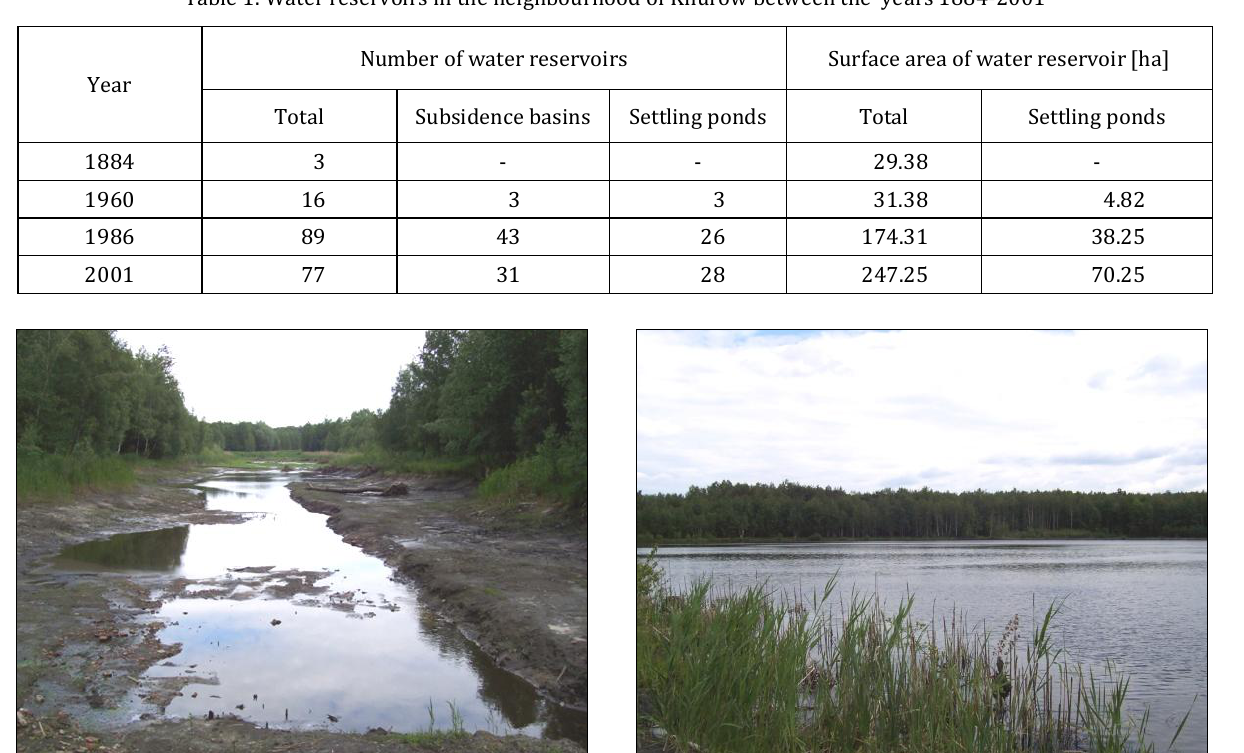
Table 1. Water reservoirs in the neighbourhood of Knurów between the years 1884-2001